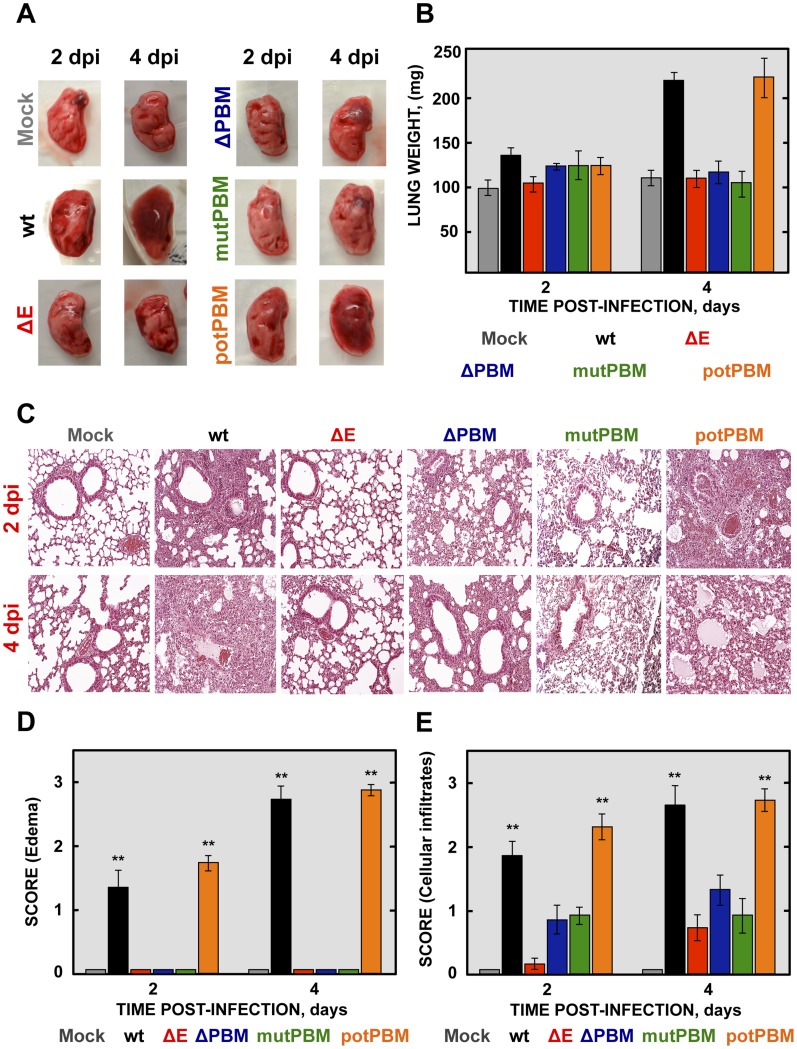
Lung pathology of mice infected with recombinant SARS-CoV-E-PBM mutants.16-week-old BALB/c mice were inoculated intranasally with 100,000 pfu of wt, ΔE, ΔPBM, mutPBM and potPBM viruses. (A) Gross pathology of mouse lungs infected with recombinant viruses at 2 and 4 dpi. (B) Weight of left lungs excised from infected mice sacrificed at the indicated days (n = 3, each day). Error bars represent standard deviations. (C) Lung tissue sections from mice infected with recombinant viruses were prepared at 2 and 4 dpi and stained with hematoxylin and eosin. Three independent mice per group were analyzed. (D and E) Pathology scoring in lung of mice infected with SARS-CoV recombinant mutants. Lungs were harvested at 2 and 4 days and scored in a blinded fashion using 3 mice per condition on a scale of 0 (none) to 3 (severe), estimated according to previously described procedures [34]. Data are presented for edema (D) and cellular infiltrates (E). Mean values are reported and statistically significant data are indicated with two (P<0.01) asterisks. Original magnification was 20x. Representative images are shown.